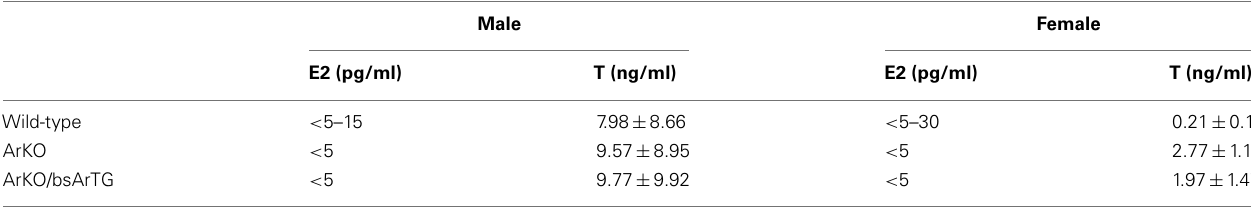
Table 1 | Serum concentrations of E2 andT in the wild-type,ArKO, andArKO/bsArTG